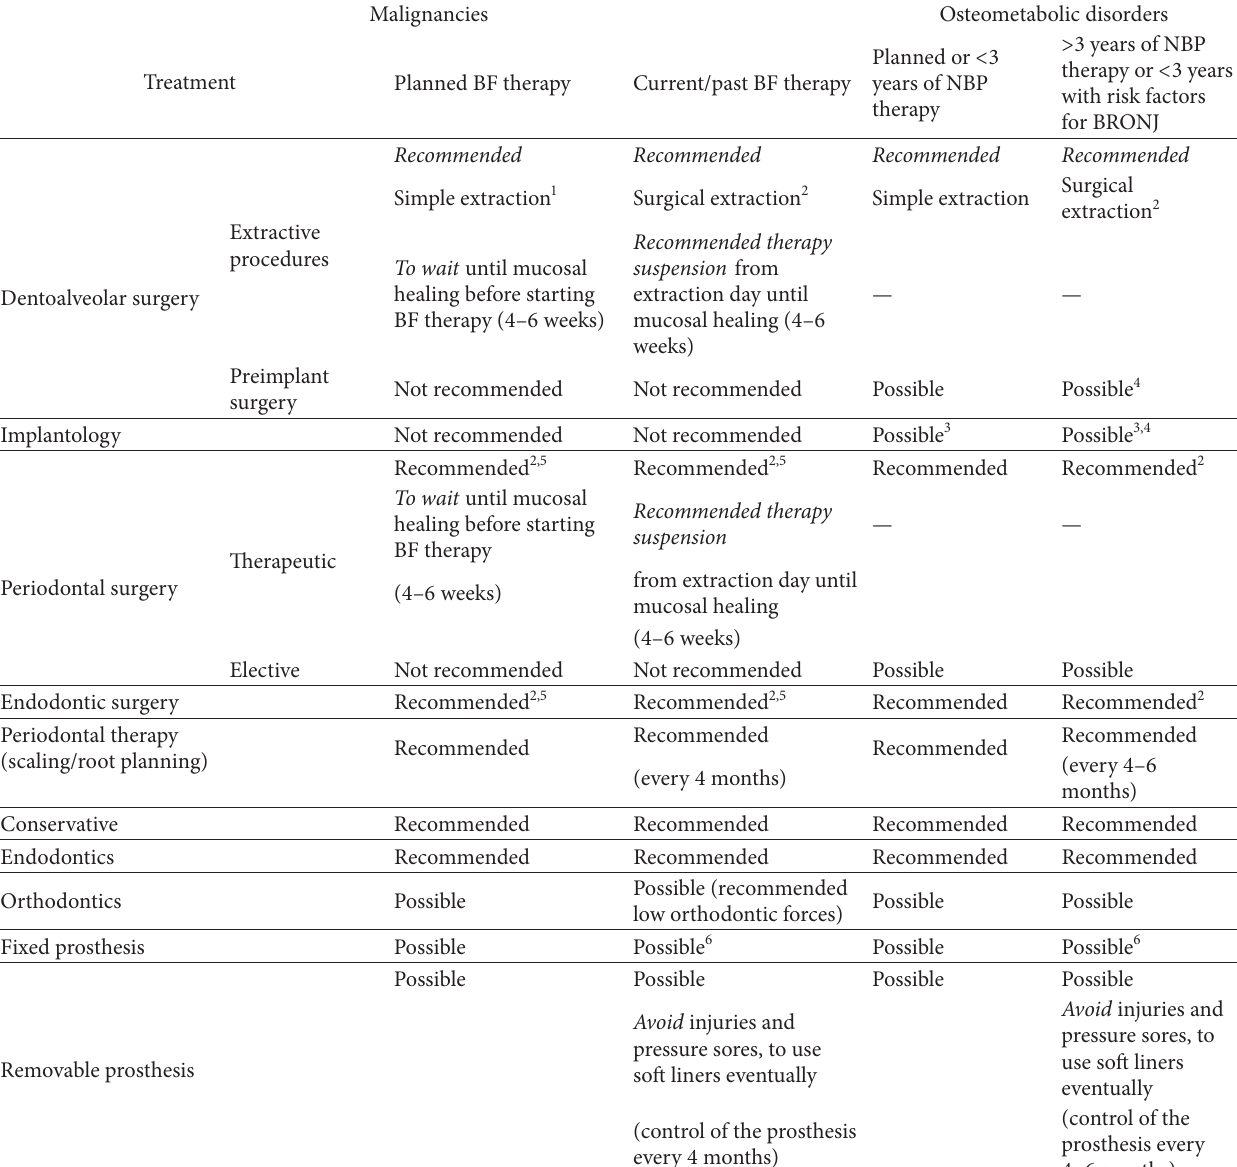
Table 2: Oral procedures in patients with current/past or planned BP therapy